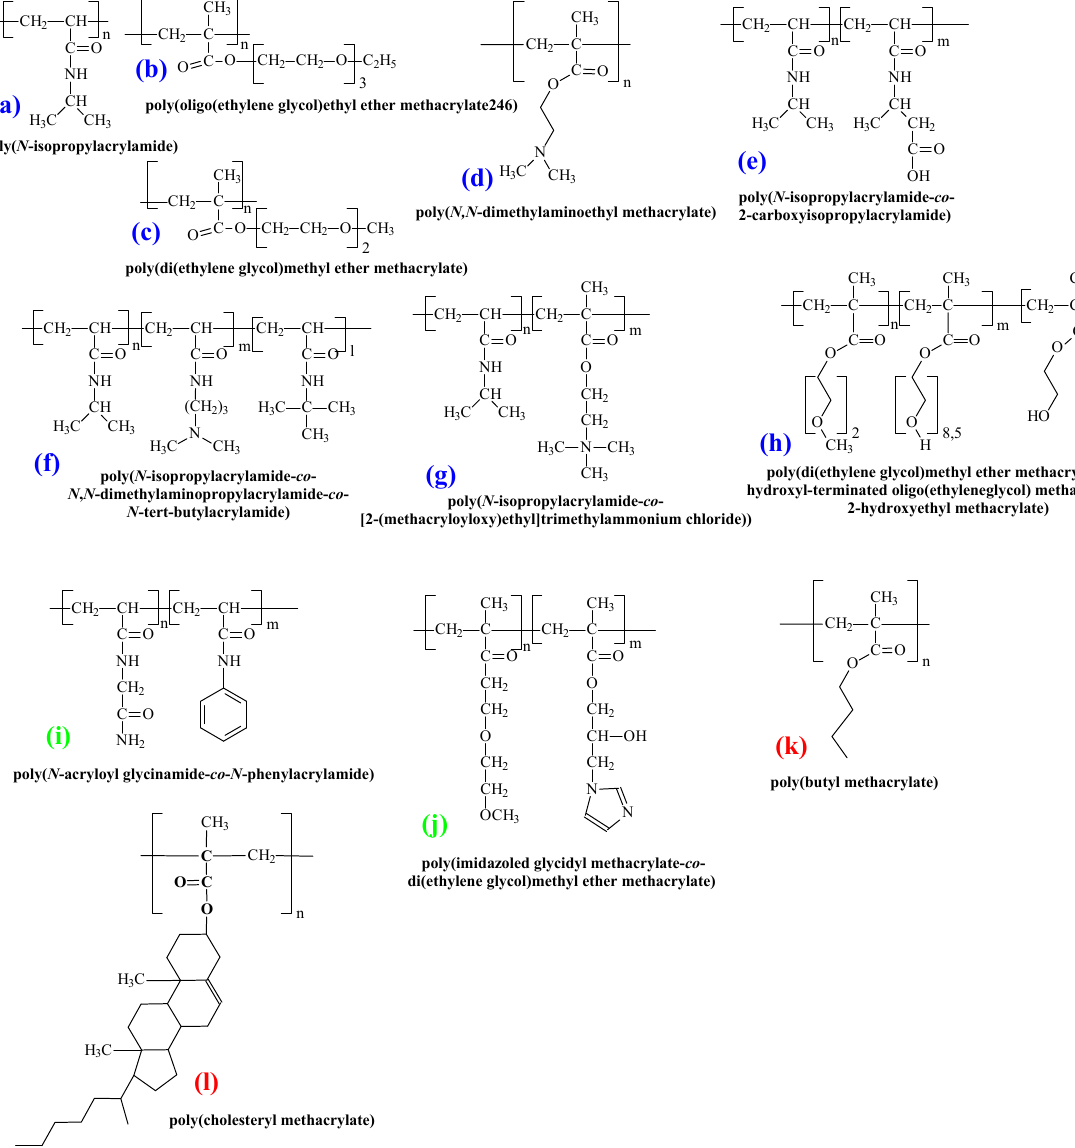
Figure 8. Chemical structures of TRPBCs for advanced biomedical applications. N -isopropylacrylamide ( a ), oligo(ethylene glycol)ethyl ether methacrylate with Mw = 246 (OEGMA246) ( b ), di(ethylene glycol)methyl ether methacrylate ( c ), N , N -dimethylaminoethyl methacrylate ( d ) and their copolymers with units from other functional monomers ( e – h ) poly( N -acryloyl glycinamide- co - N -phenylacrylamide) ( i ), poly(imidazoled glycidyl methacrylate- co -diethylene glycol methyl ether methacrylate) ( j ), poly(butyl methacrylate) ( k ) and poly(cholesteryl methacrylate) ( l ).